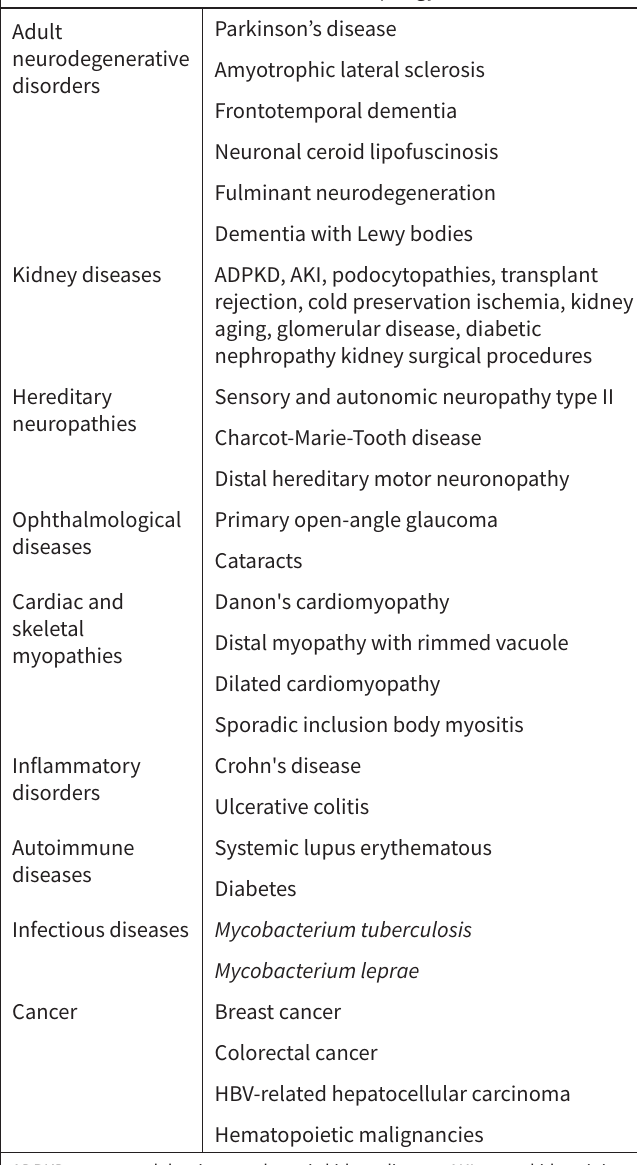
Table 1. Diseases Associated with